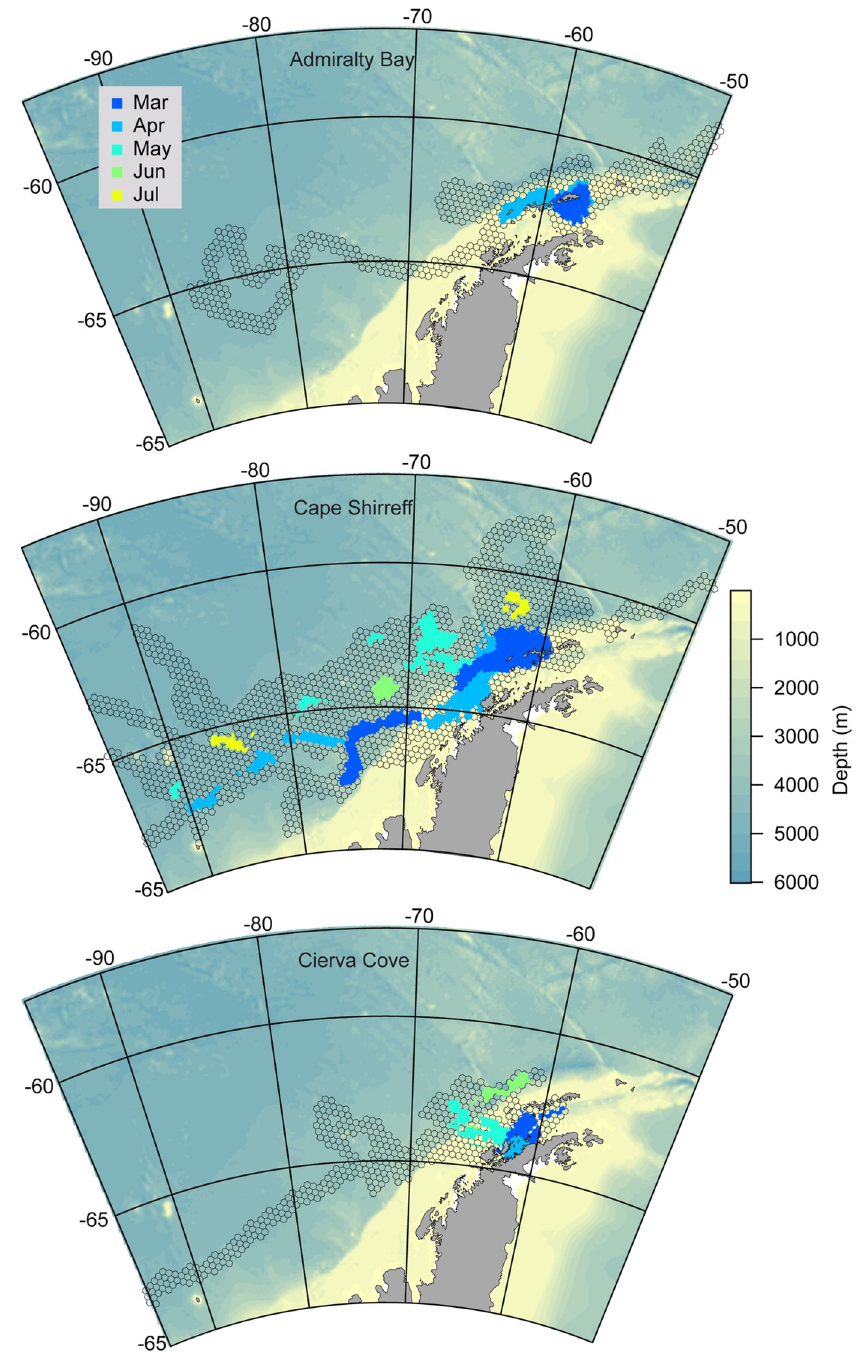
Fig 7. Intra-colony overlap maps. Monthly intra-colony overlap maps for individuals from Admiralty Bay, Cape Shirreff, and Cierva Cove. For reference, the background HUD (gray polygons) is the colony-specific total HUD for all months